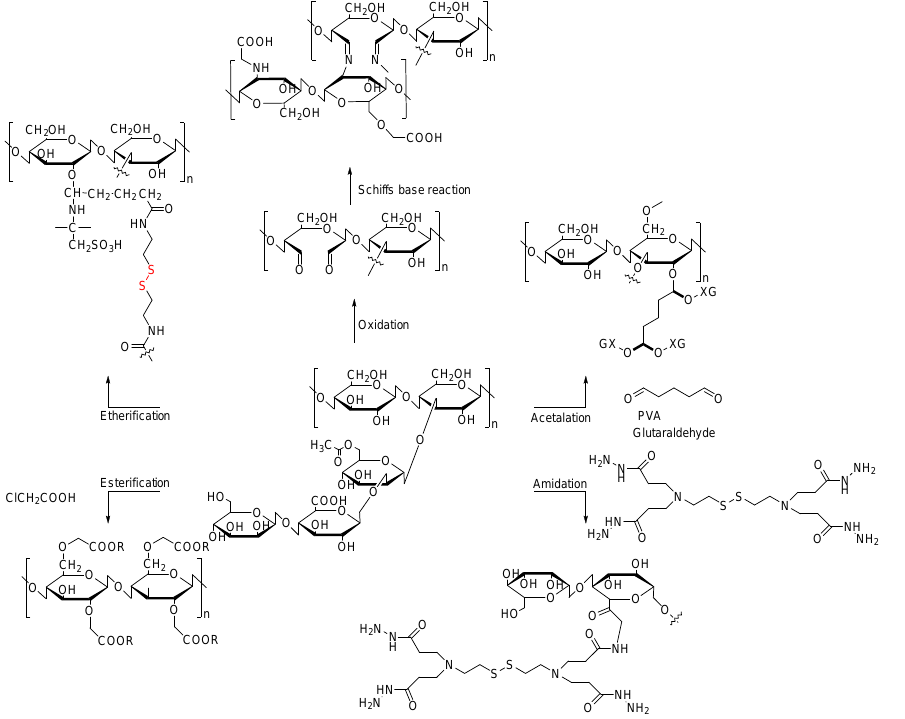
Figure 2. The structure and different modifications of Xanthan gum.